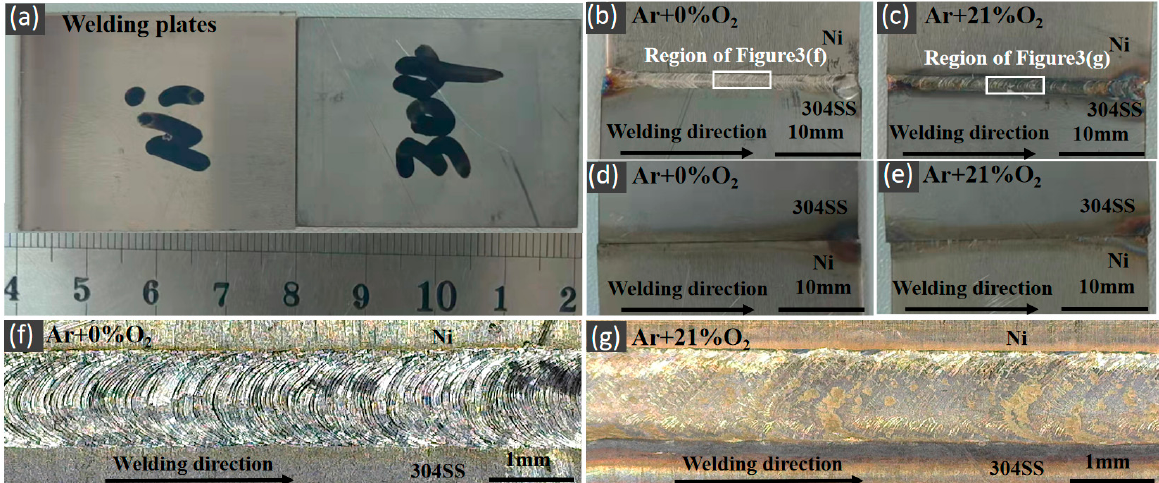
Figure 3. Images of welding plates and the surface of welding beads in different atmospheres. ( a ) Welding plates; ( b ) top view of a welding bead in pure argon; ( c ) top view of a welding bead in the AMO; ( d ) back view of a welding bead in pure argon; ( e ) back view of a welding bead in the AMO; ( f ) morphology of the top surface of a welding bead in pure argon; and ( g ) morphology of the top surface of a welding bead in the AMO.